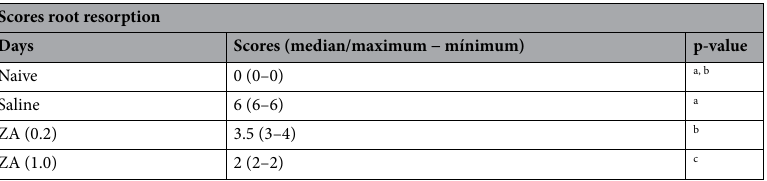
Table 1. Histopathological analysis of the effect of ZA on root resorption, expressed in scores. Significant bold value if p < 0.05. (a) Association between the Naive versus Saline groups—p < 0.000. (b) Association between the Naive versus ZA groups (0.2)—p = 0.015. (c) Association between the Saline versus ZA groups (1.0)—p = 0.015 (Kruskal–Wallis test followed by pos-hoc Dunn’s test).